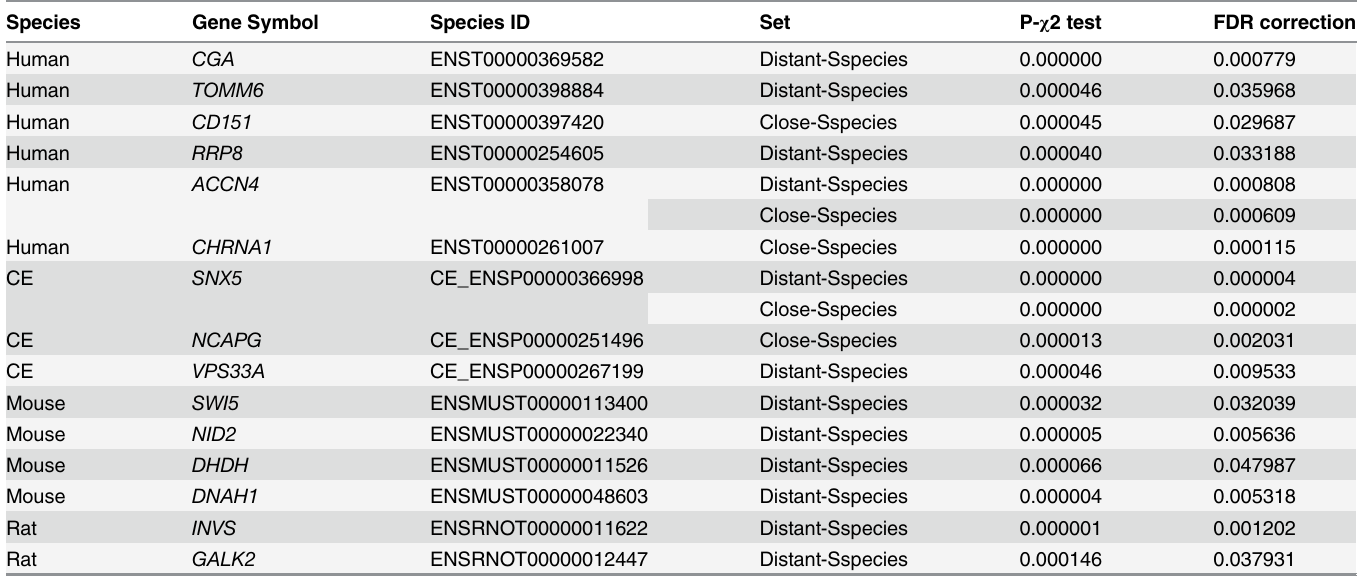
Table 3. Positively-selected genes in non-seasonal species filtered by SP scoring and corrected by cDNA